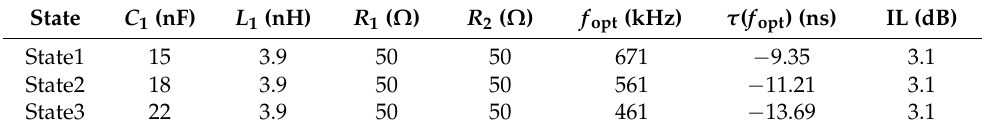
Table 4. Data of high-pass negative group delay circuit with different C 1 .